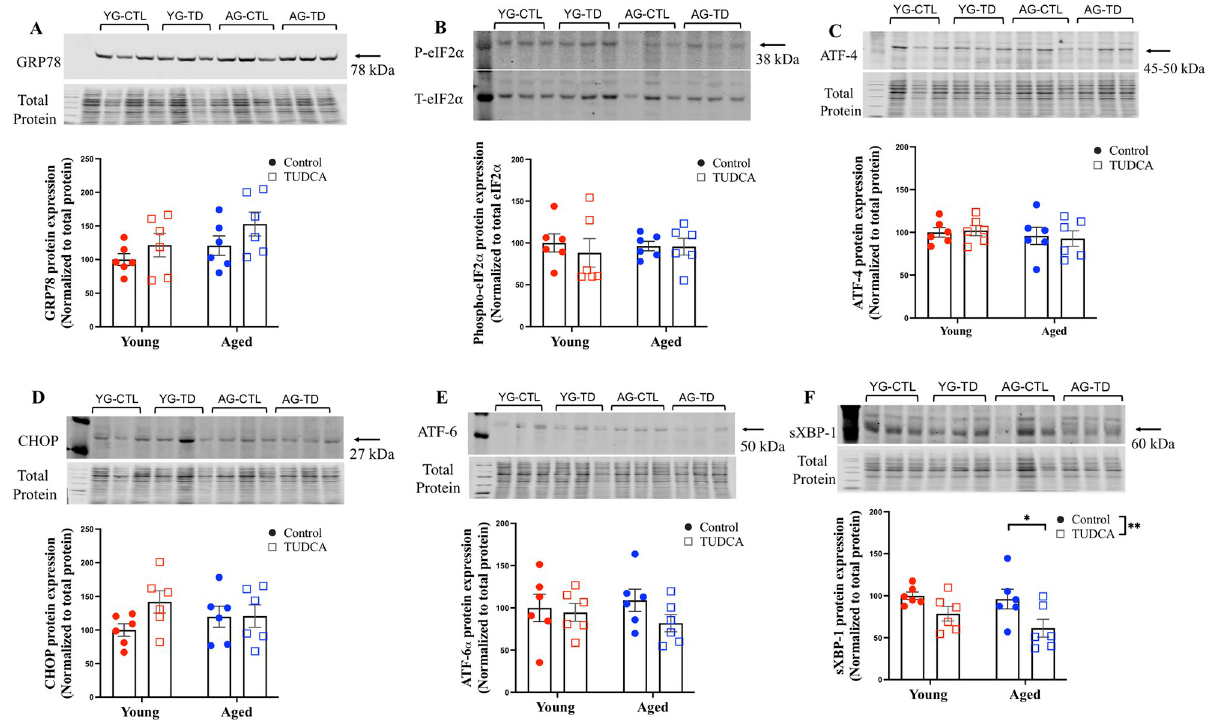
Fig 5. Female junctional zone. Western blot analysis of female junctional zone (A) GRP78, (B) phospho-eIF2 α , (C) ATF-4, (D) CHOP, (E) ATF-6 α , and (F) sXBP-1 normalized to total protein (except phospho-eIF2 α normalized to Total eIF2 α ) in female placenta junctional zone of young (3–4 months; in red) and aged control dams (9–9.5 months; in blue) with (open squares) or without (closed circles) TUDCA-treatment on gestational day 20. Data are presented as mean ± SEM and expressed as percentage of control (i.e., the mean of the young control dams); analyzed by two-way ANOVA with Sidak’s multiple comparisons post-hoc test; * p < 0.05; n = 6/group. YG-CTL = Young control dams; YG-TD = Young TUDCA-treated dams; AG-CTL = Aged control dams; AG-TD = Aged TUDCA-treated dams.